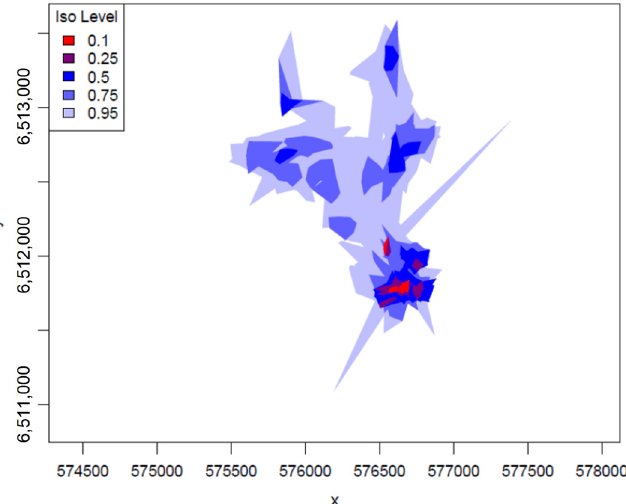
Figure 5. Isopleths constructed in different hulls sorted by area, indicating proportions of the total points enclosed by sheep during the dry season. points enclosed by sheep during the dry